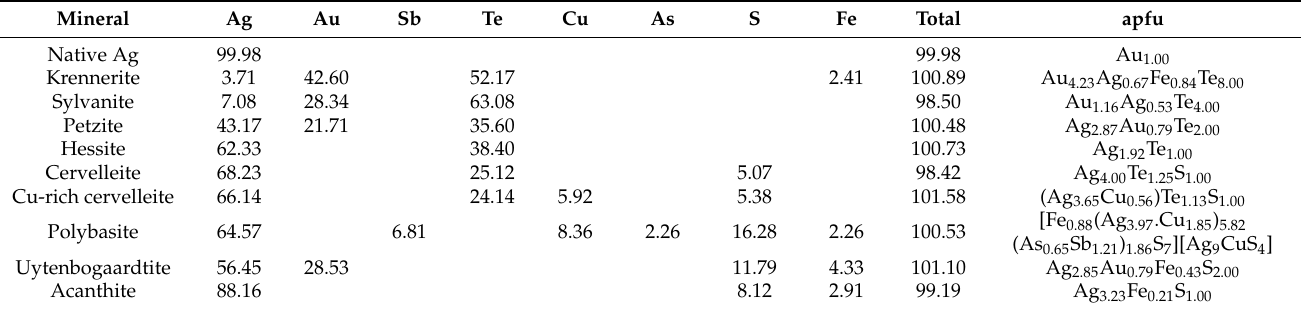
Table 3. Chemical composition of Au, Ag, and Te minerals (in wt.%).